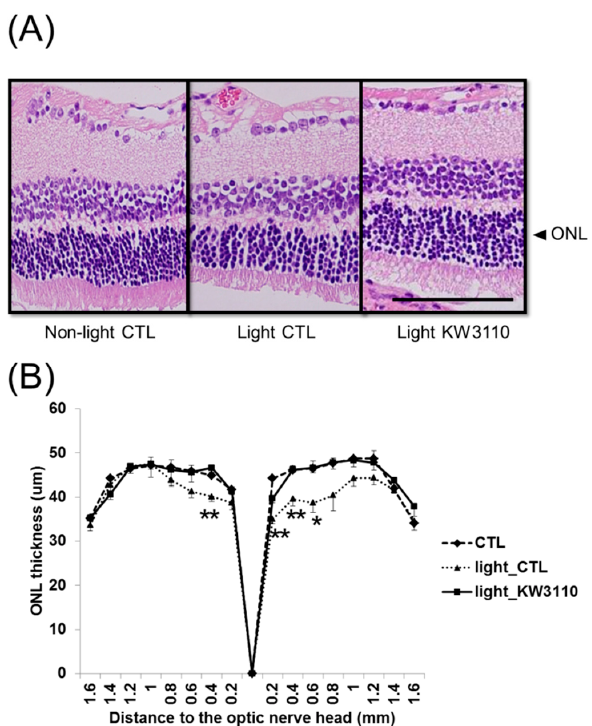
Figure 3. A protective effect of L. paracasei KW3110 on light-induced histological retinal changes. ( A ) Hematoxylin and eosin staining of retinal sections. Arrow heads indicate the outer nuclear layer (ONL). Scale bar represents 100 µm. ( B ) ONL thickness was lower in mice fed a control diet than in mice fed a diet with L. paracasei KW3110. Values are presented as the mean ± SEM. Significance was assumed if the p value was < 0.05. * p < 0.05; ** p < 0.01; non-light CTL, no light exposed mice group fed a control diet; light control, light exposed mice group fed a control diet; light KW3110, light exposed mice group fed a diet containing L. paracasei KW3110.